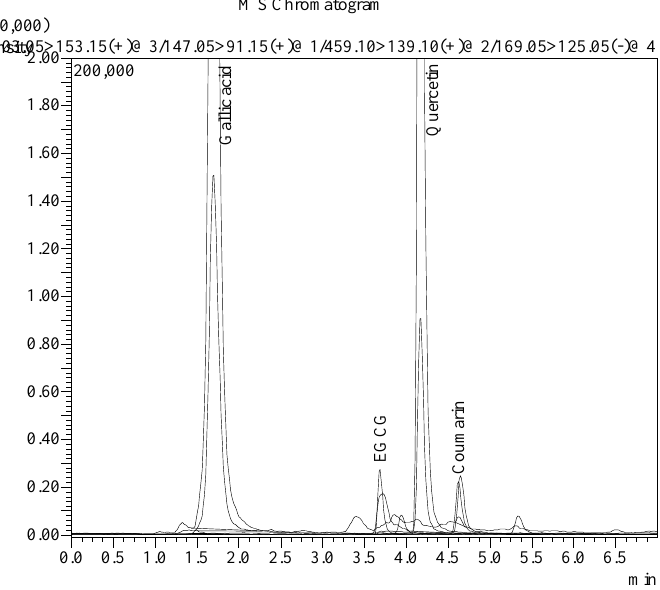
Figure 6. Overlay of LC–MS/MS extracted ion chromatograms (EIC) for B. flabellifer male flower ethanolic